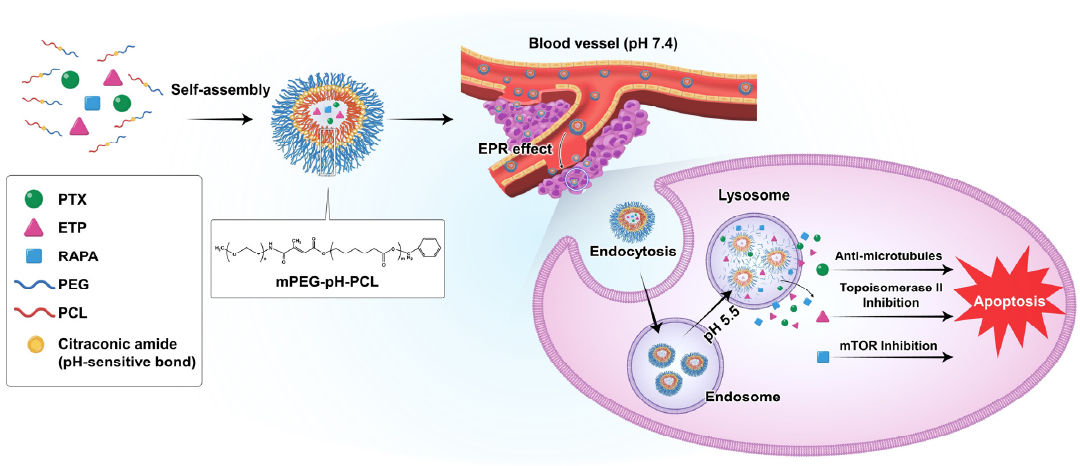
Figure 1. Schematic diagram of the drug release of paclitaxel (PTX), etoposide (ETP), and rapamycin (RAPA)-loaded mPEG-pH-PCL micelles in response to pH changes.